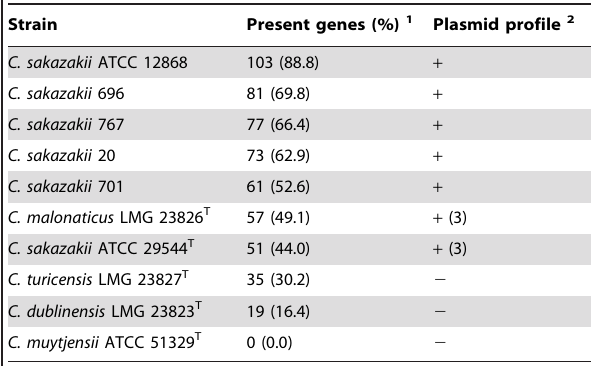
Table 3. pESA3 genes present in Cronobacter strains